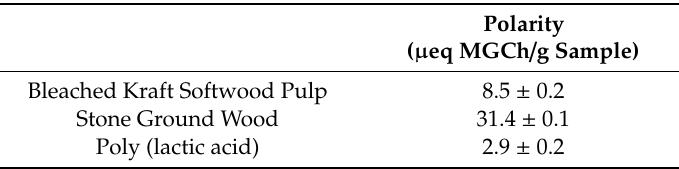
Table 2. Polarity values of BKSP and